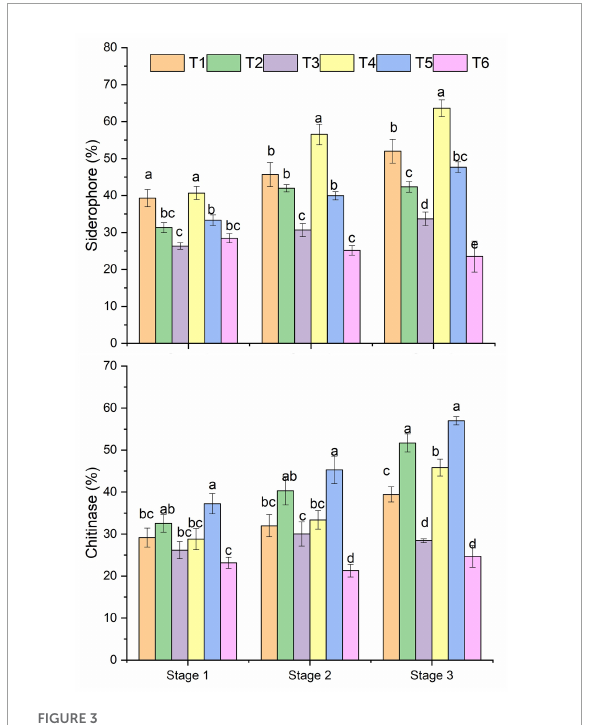
FIGURE3 Microbial siderophore and chitinase frequency of bacteria isolated from different treatments. Mean values ( n = 3) in the same column followed by the same letter(s) are not significantly different at ( P < 0.05) according to the DMRT test. Treatment details as Figure 2